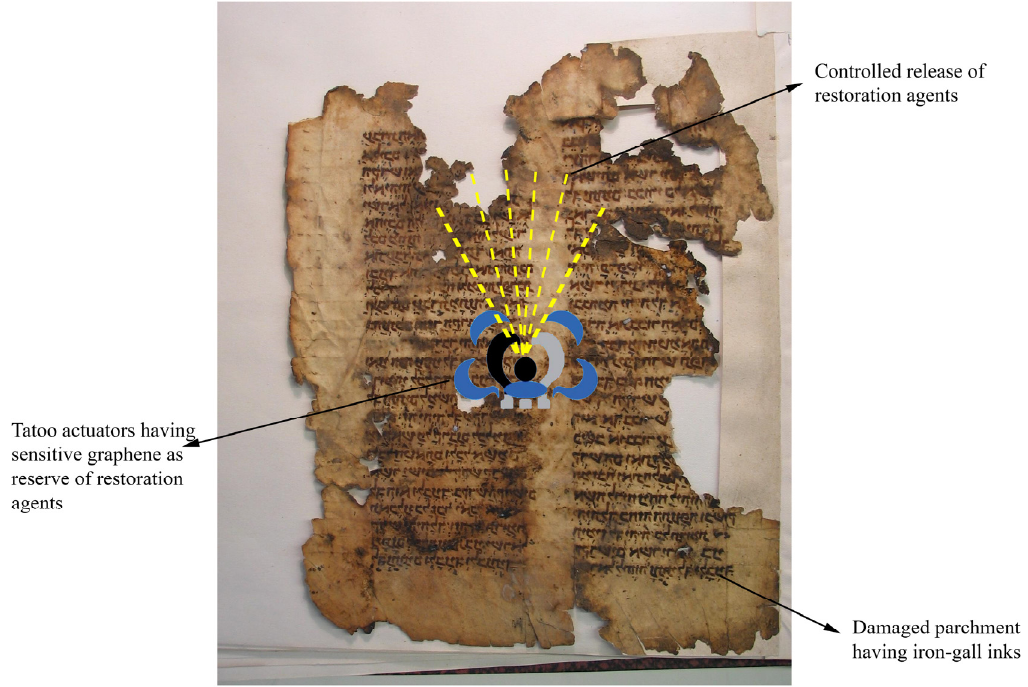
Figure 3. Layer ‐ by ‐ layer fabrication of the potentiometric tattoo sensor, as reported by Guinovart et al. [76]. The authors, display a cartoon to explain a future applications of tattoo sensors for the “ in situ ” detection of adsorbed pollutants and damages, on the CH surfaces.